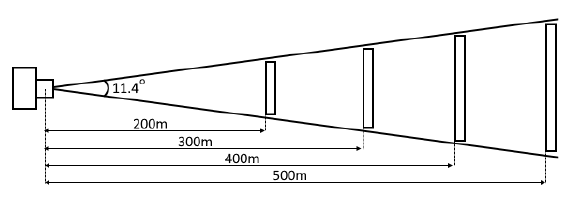
Figure 8. Scheme of the simulated images location.